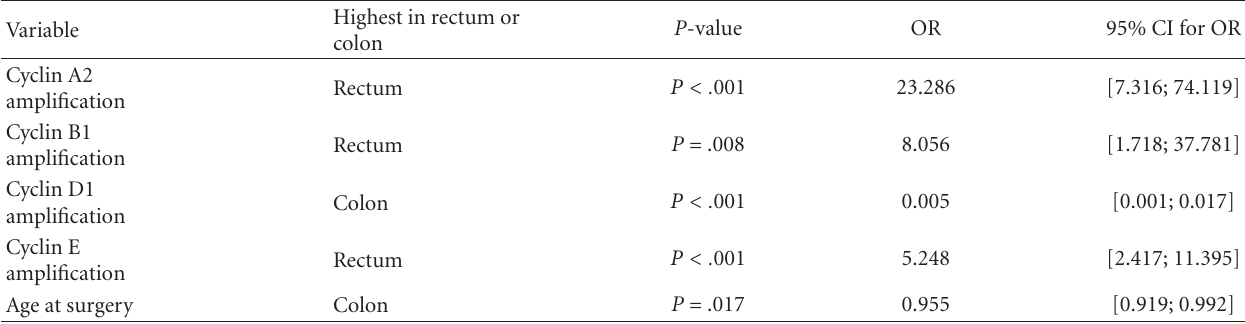
Table 5: Gene amplification. Variables that showed a significant di ff erence between rectal cancers and colon cancers (results of binary logistic regression analysis on 403 patients).